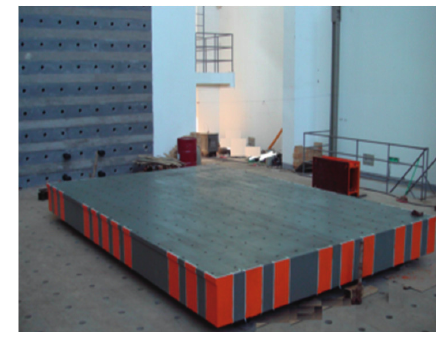
Figure 7: Shaking